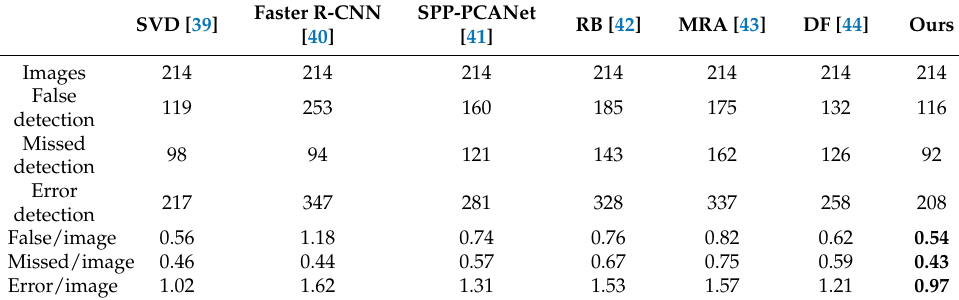
Table 6. Mean error rate comparison results of the different